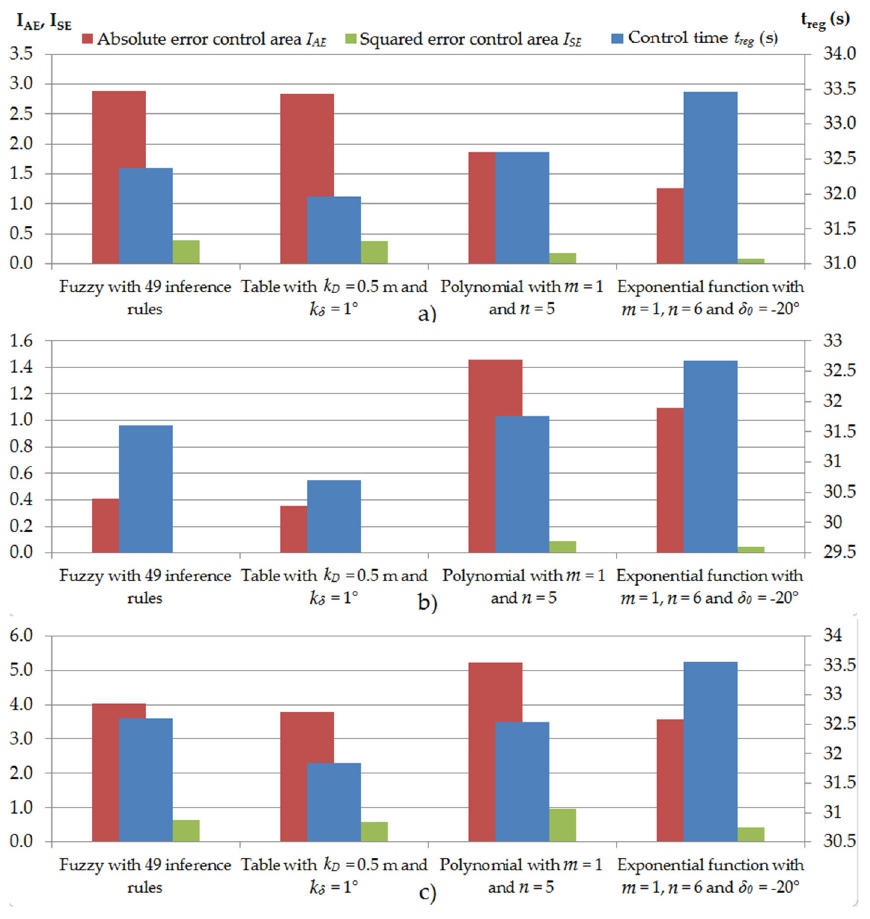
Figure 16. EN20 mobile robot control quality values in real-world tests for different starting angles: ( a ) − 90°; ( b ) 0°; ( c ) 90°.